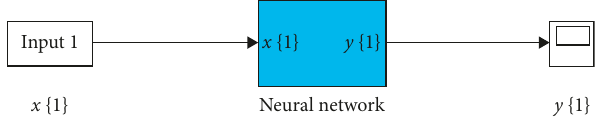
Figure 15: The ANN inverse model of the MR damper in